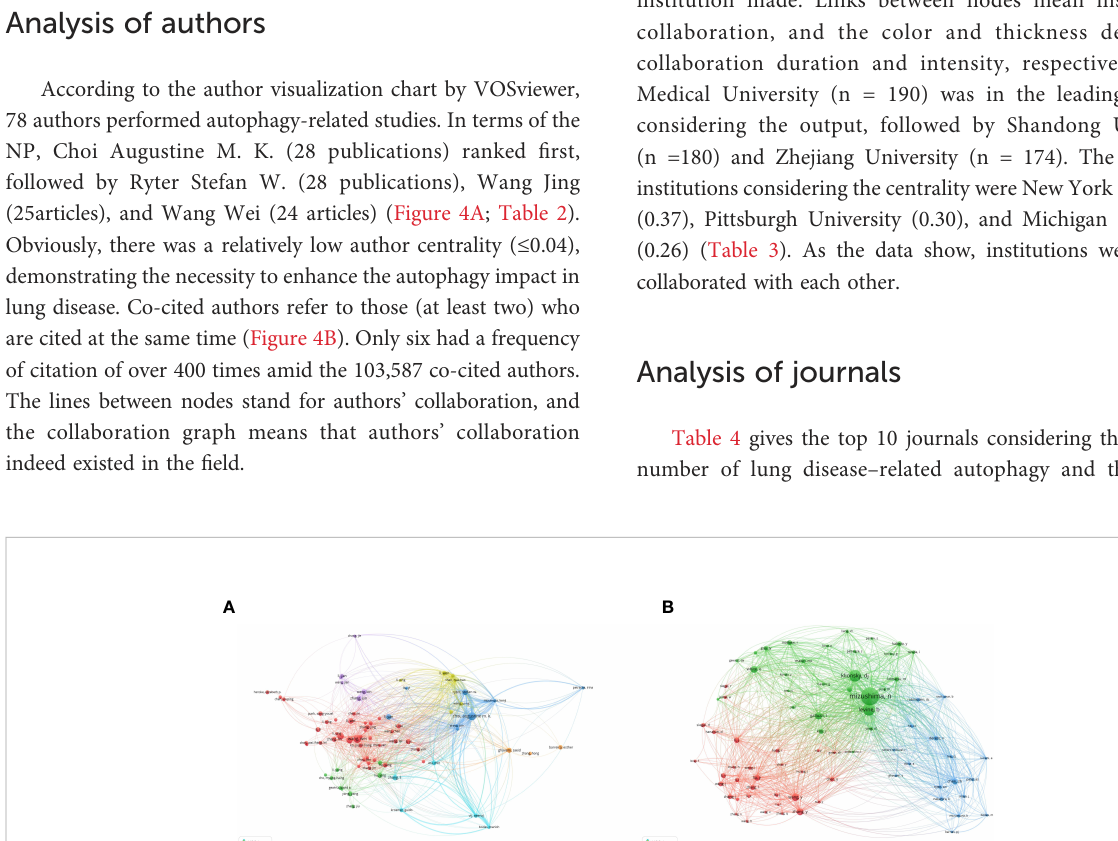
Figure 5 is an institutional co-occurrence map built with and centrality in autophagy-related lung disease studies. Nodes